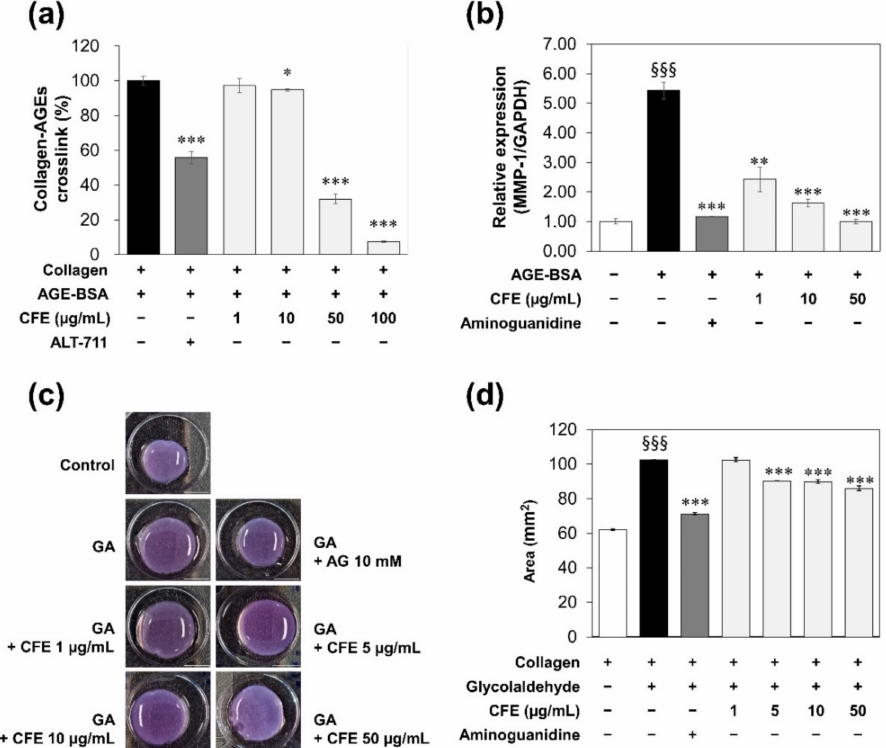
Figure 3. Effects of CFE on glycation of collagen. ( a ) The breaking activity on crosslinks of collagen– AGEs. These data were represented as a percentage (%) of the absorbance of the sample compared to the control (collagen+/AGE+). ( b ) MMP-1 expression in normal human fibroblast. The level of mRNA transcripts encoding MMP-1 and GAPDH were determined by RT-qPCR after 72 h treatment of AGE-BSA, AG, and CFE. These data were represented in relative expression of MMP-1 to GAPDH . GAPDH is a housekeeping gene used as a control. ( c ) The images and ( d ) the areas of 3D collagen lattices after inducing 72 h gel contraction. Statistical significances were represented as follows: *, p < 0.05; **, p < 0.01; ***, p < 0.001 compared to the control group; §§§, p < 0.001 compared to the untreated